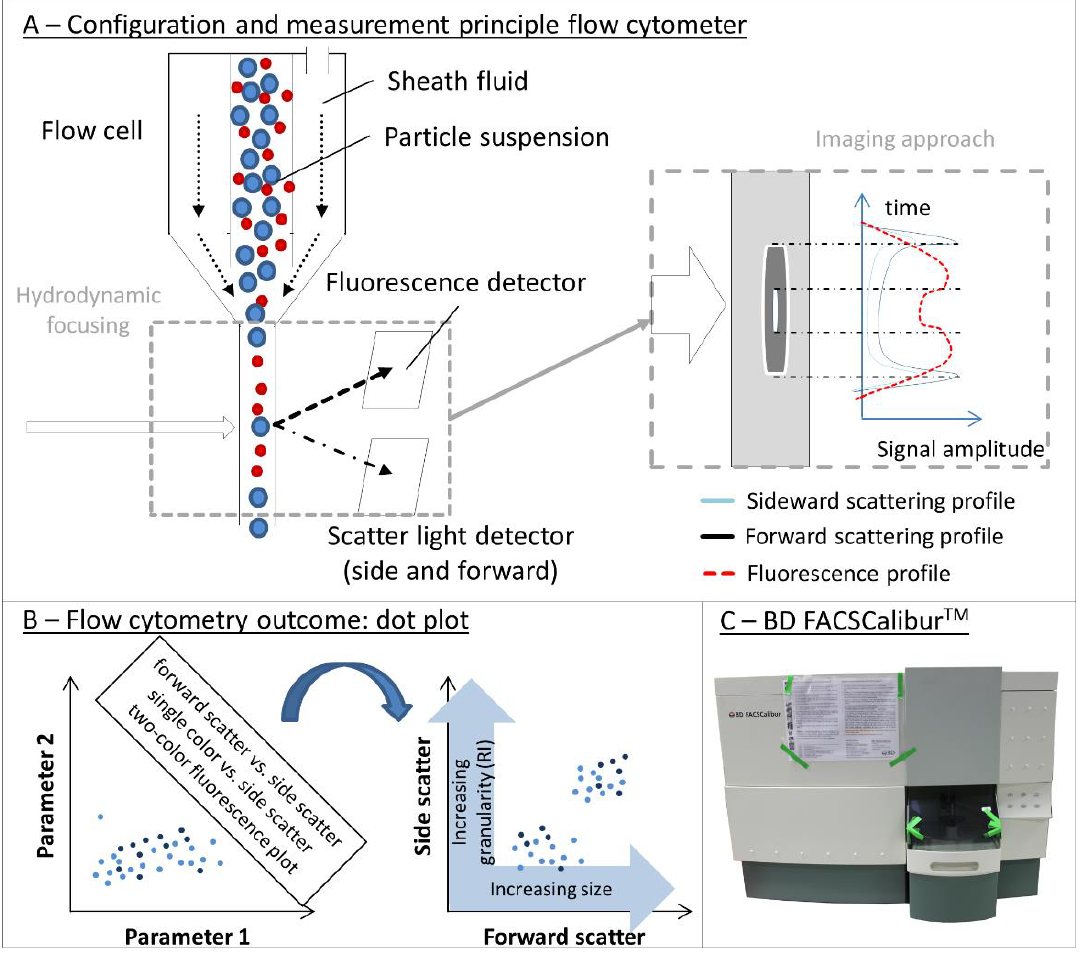
Figure 8. Flow cytometry (FC): instrument, measuring principle, and final outcome. ( A ) Schematic illustration of the measurement principle of a flow cytometry instrument. The particle suspension is injected into a flow cell. On the outer side a sheath fluid is applied and results into a hydrodynamic focusing. After this focusing the suspension enters a narrow capillary. At a fixed position of the capillary a light beam encounters the particle and the fluorescence signal as well as the scattered light (sideward and forward) is detected (left part). An emerging approach is the recording of a specific signal profile (right part) which leads to a more detailed characterization and even visualization of each particle. ( B ) The final results of FC measurements are dot plots considering multiple detected parameters, e.g., fluorescence, forward scattering or sideward scattering. ( C ) Exemplary, the BD FACS Calibur as a flow cytometer enabling particle detection and characterization.